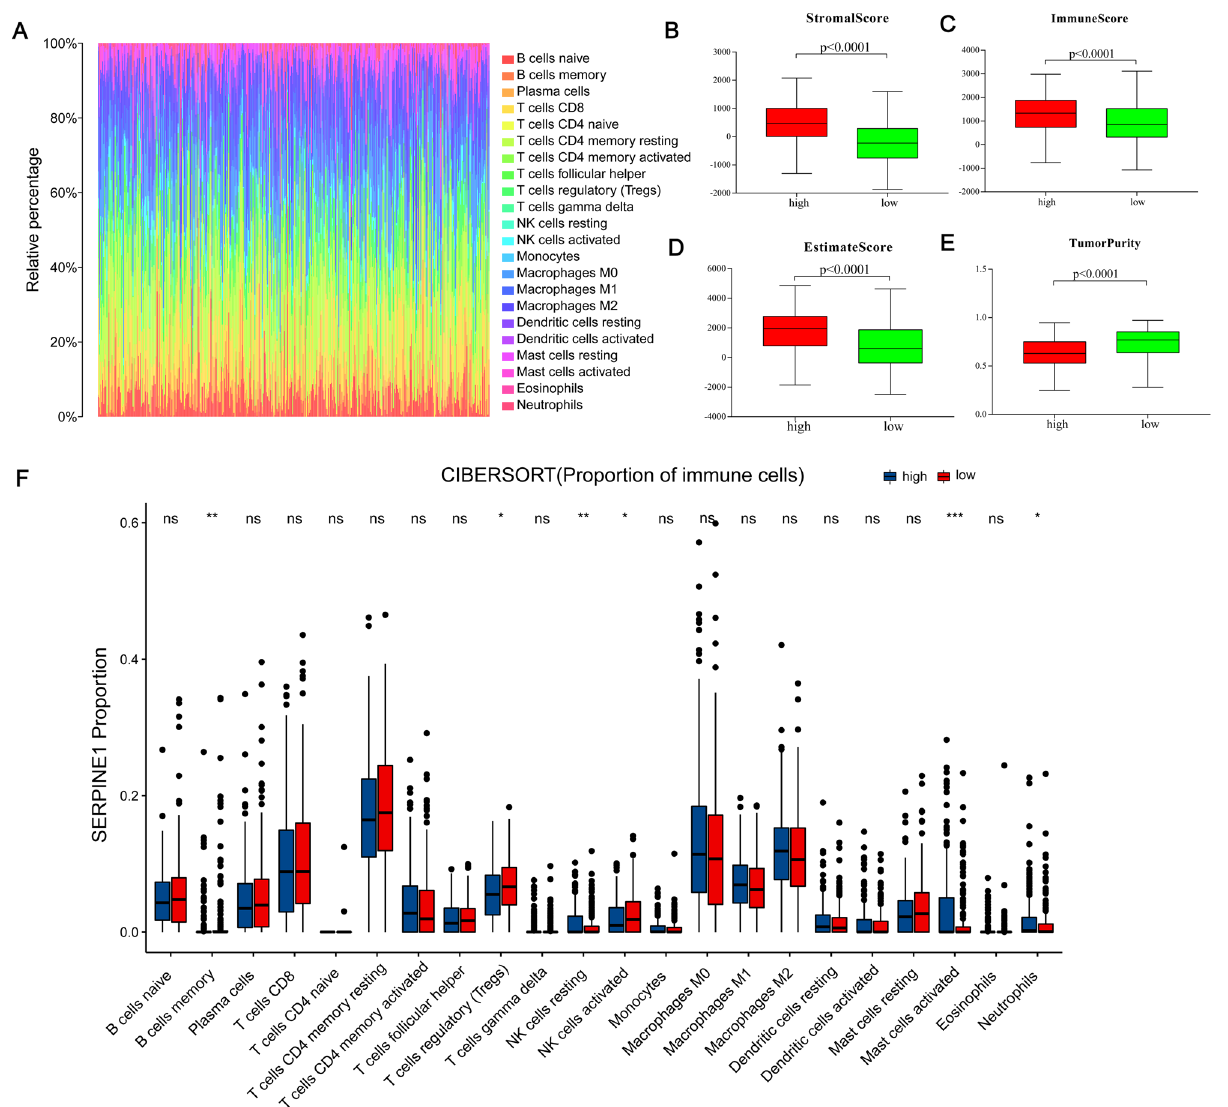
Figure 6. Comparison of Immune Cell Proportion and Immune Score between High and Low Expression of SERPINE1. ( A ) Bar chart of the proportion of 21 immune cells in STAD tumor samples. ( B ) The correlation between the expression of SERPINE1 and the stromal score. ( C ) The correlation between the expression of SERPINE1 and the immune score. ( D ) The correlation between the expression of SERPINE1 and the estimate score. ( E ) The correlation between the expression of SERPINE1 and the tumor purity. ( F ) The correlation between the expression of SERPINE1 and the proportion of immune cells. The P values are labeled using asterisks ( * p < 0.05, ** p < 0.01, *** p < 0.001, ns, not significant, p >